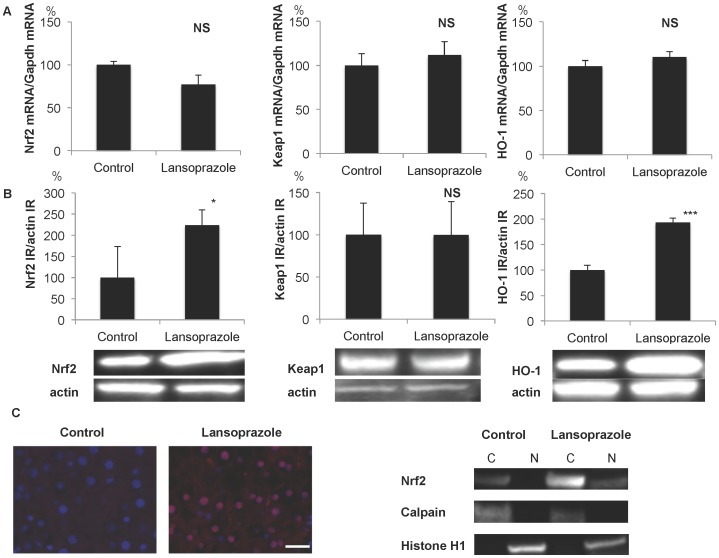
Up-regulation of Nrf2 and HO-1 following successive subcutaneous treatments with lansoprazole.A) No significant changes in the levels of mRNA for Nrf2, Keap1 and HO-1. B) Up-regulation of IR levels for Nrf2 and HO-1, with no change of Keap1 IR. *P<0.05, ***P<0.001 compared with control. Representative photographs showing an increase of Nrf2 and HO-1 IR. C) Nuclear translocation of Nrf2 in hepatocytes as demonstrated by double fluorescence immunohistochemistry and western blotting of cytosol fraction (C; Calpain-positive) and nuclear fraction (N; Histone H1-positive). Blue indicates DAPI-positive nuclei, red indicates Nrf2 IR, and pink indicates the nuclear localization of Nrf2. Bar = 20 µm.